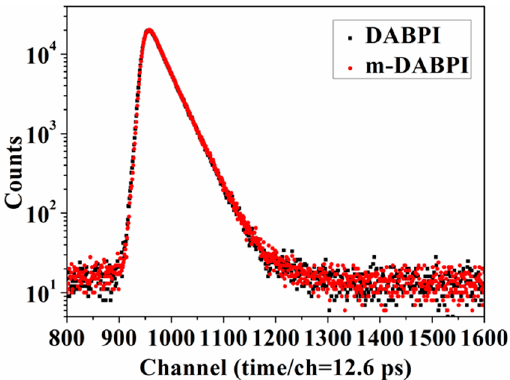
Figure 6. Positron lifetime spectra of DABPI and m-DABPI films.